Question: Condense the content of this figure into a single sentence.
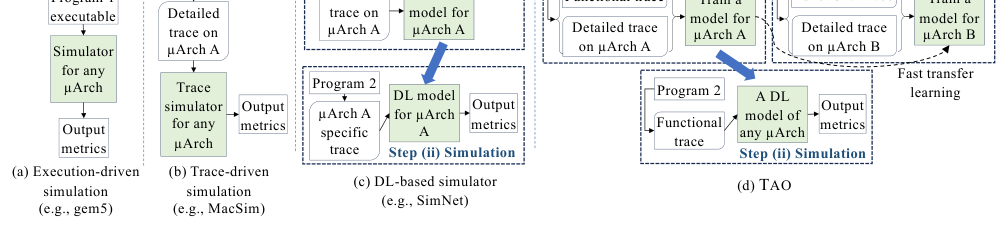
Answer: Mainstream simulation mechanisms vs. our effort, i.e., Tao.